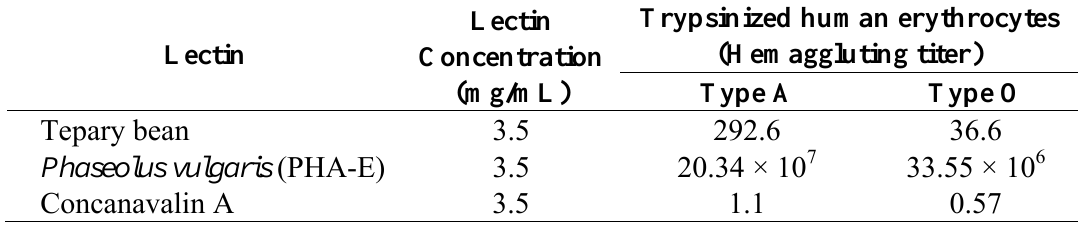
Table 5. Hemagglutination activity of the purified lectin from Phaseolus acutifolius compared with that of the lectin from Canavalia ensiformis (Concanavalin A) on trypsinized human erythrocytes of blood types A and